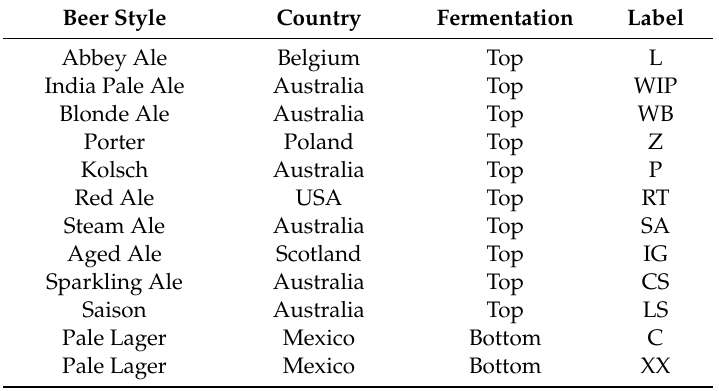
Table 1. Beer samples analyzed, and their labels utilized for the